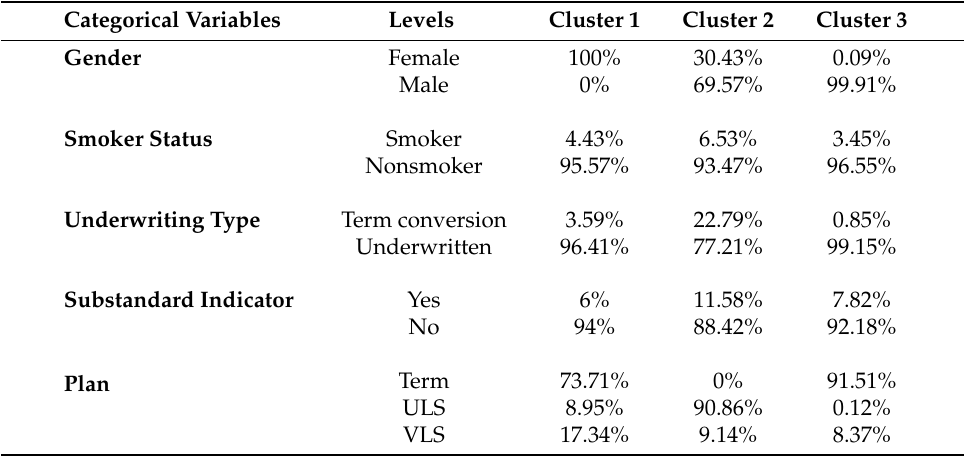
Table A2. Data summary for categorical variables within the 3 optimal clusters.